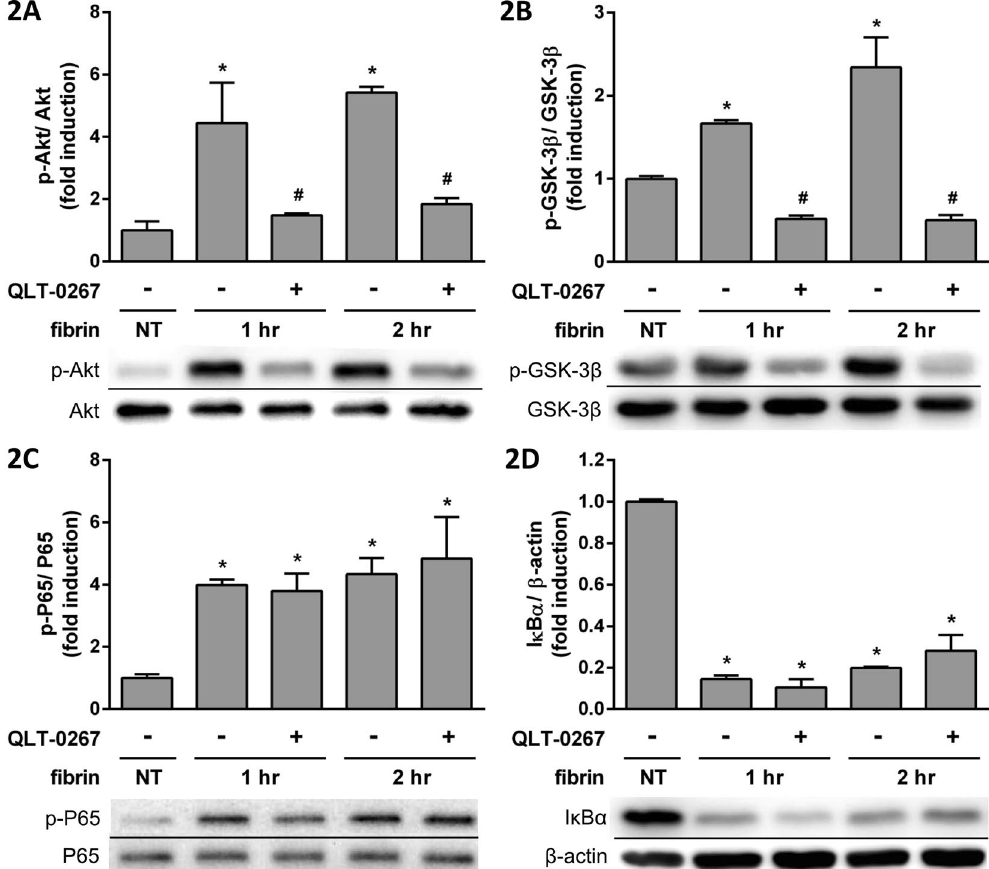
Figure 2. PMCs were overlaid with fibrin via incubation with a fibrinogen and thrombin mixture for 0, 1 and 2 hr. The effects of QLT-0267 treatment on the expression of transduction factors were evaluated in triplicate by Western blotting. The relative expression of ( A ) p-Akt vs. Akt, ( B ) p-GSK-3 β vs. GSK-3 β , ( C ) p-P65 vs. P65 and ( D ) I κ B α vs. β -actin are presented as a percentage of increase over untreated PMCs (NT). * P < 0.05 vs. NT; # P < 0.05 vs. fibrin only at the same incubation